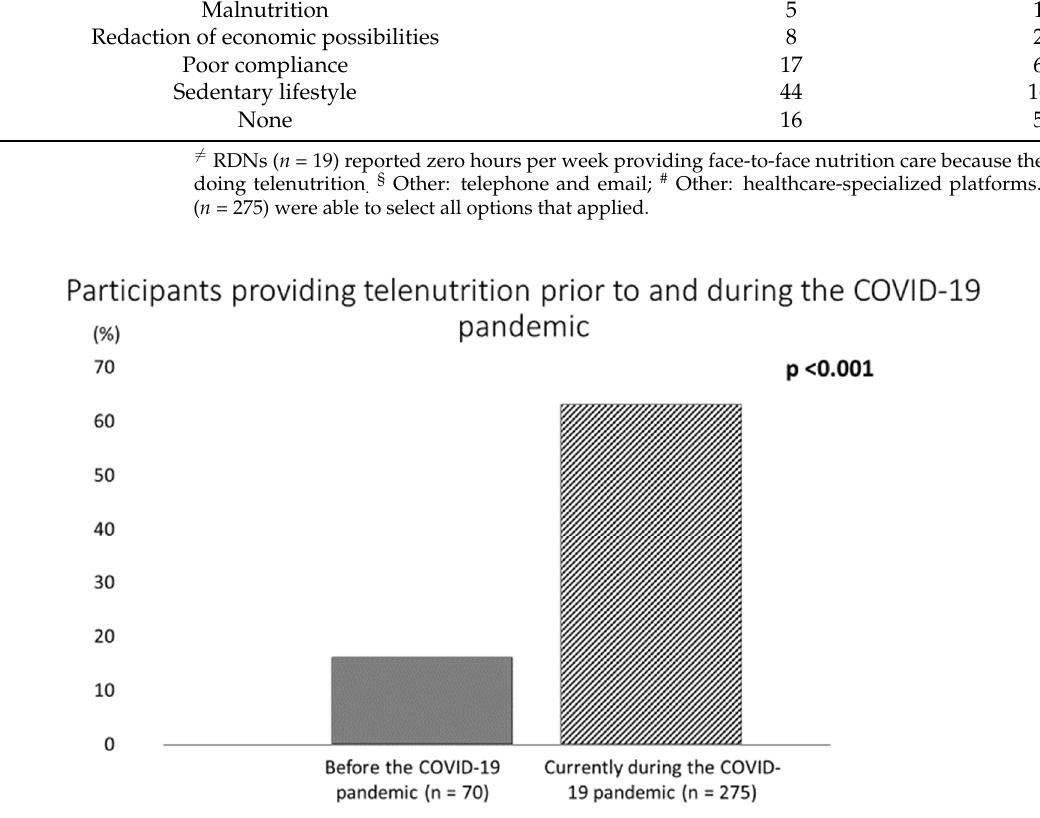
Table 2. Participants’ professional experiences providing telenutrition prior to and during the COVID ‐ 19 pandemic.